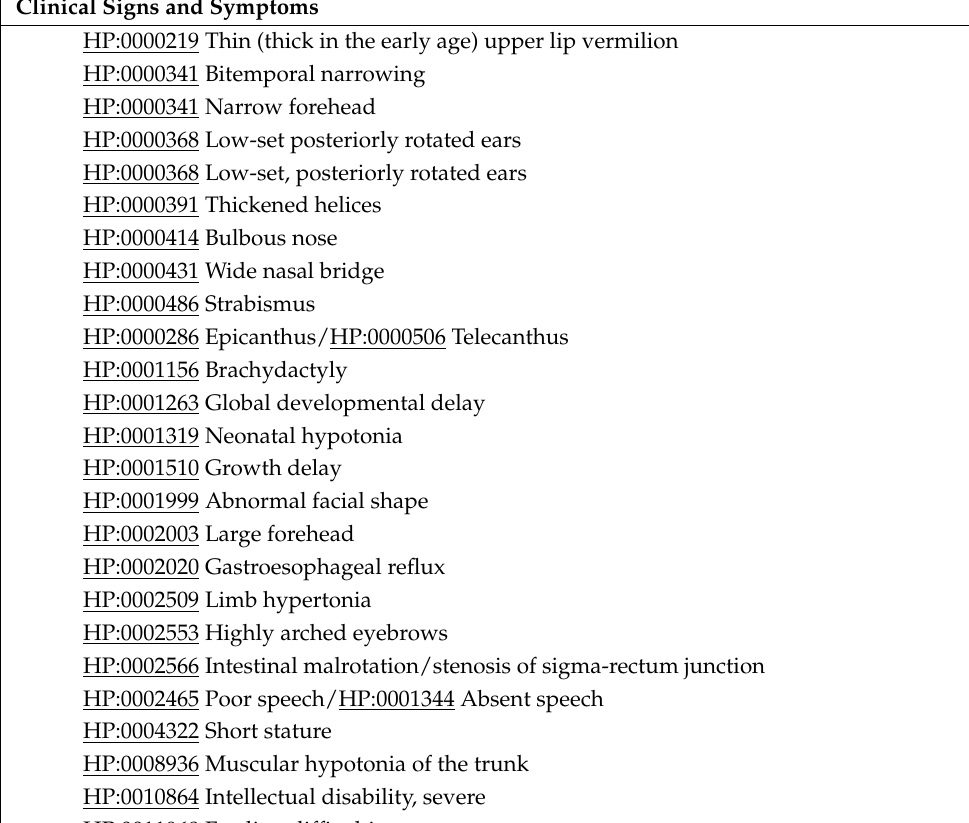
Table 2. Clinical signs and symptoms in order of HP number (modified from Phenomizer). Clinical Signs and